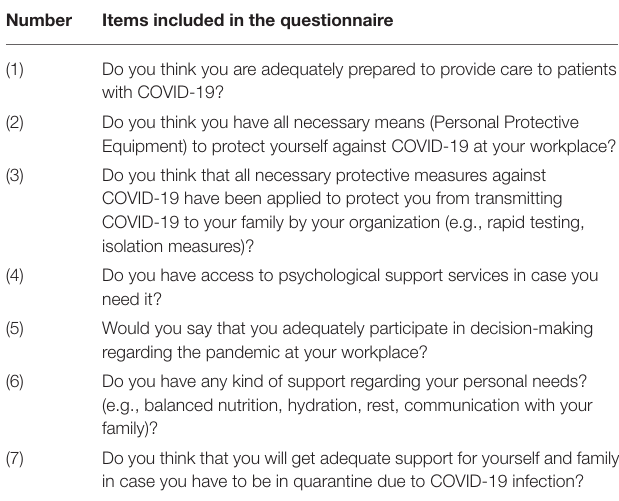
TABLE 1 | Perceived organizational support (POS)